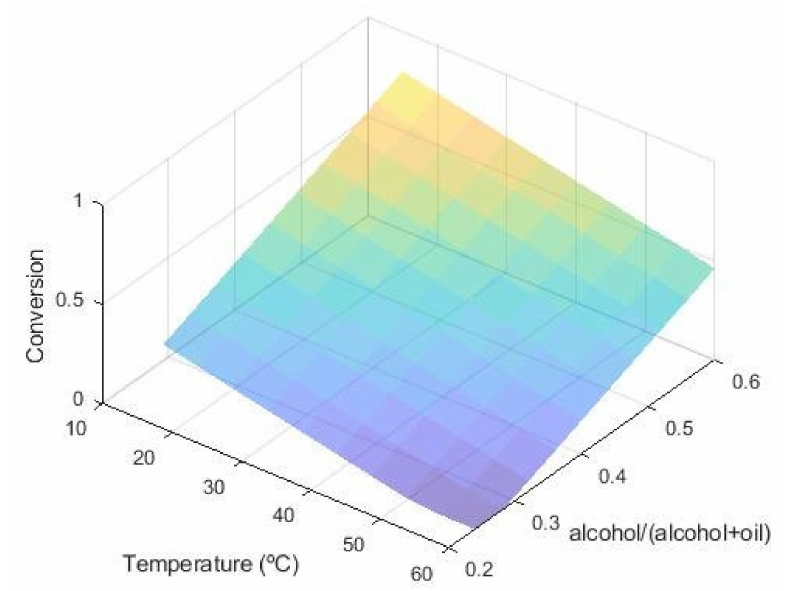
Figure 3. Transition from heterogeneous (purple) to homogeneous (yellow) system, depending on the reaction conditions and on the oil conversion